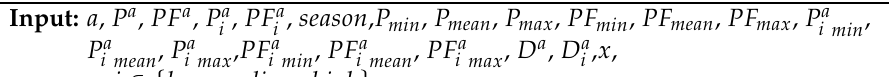
Algorithm 2: CC-AD Algorithm